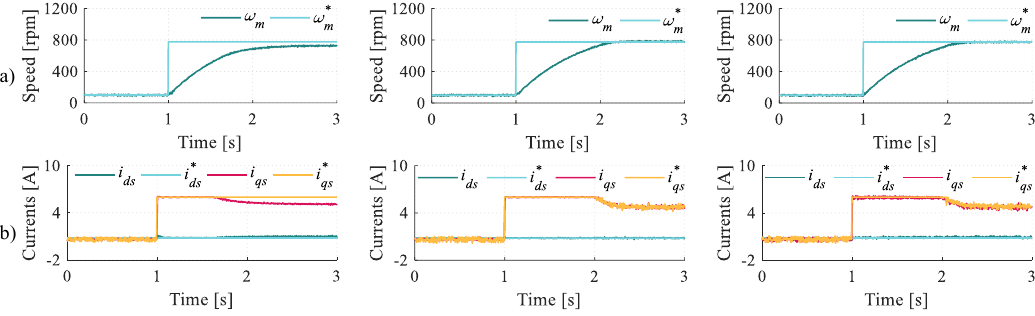
Figure 12. Test 3B . Speed-step response for V dc = 267 V for IRFOC CB-PWM ( left ), IRFOC SV-PWM ( center ) and LFCS-MPC ( right ). From top to bottom: ( a ) Mechanical speed and ( b ) d − q